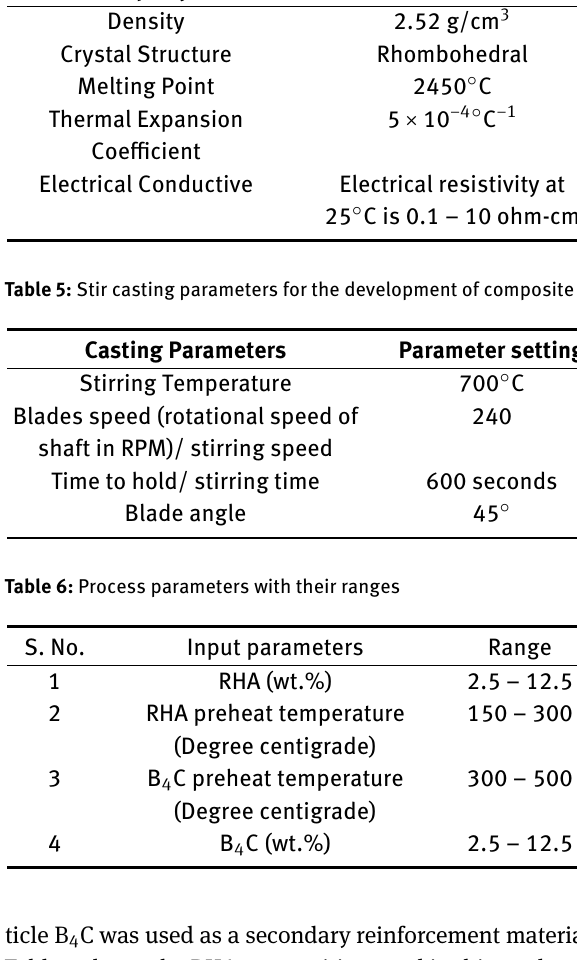
Table 4: Properties of B 4 C ceramic particles [15] Property